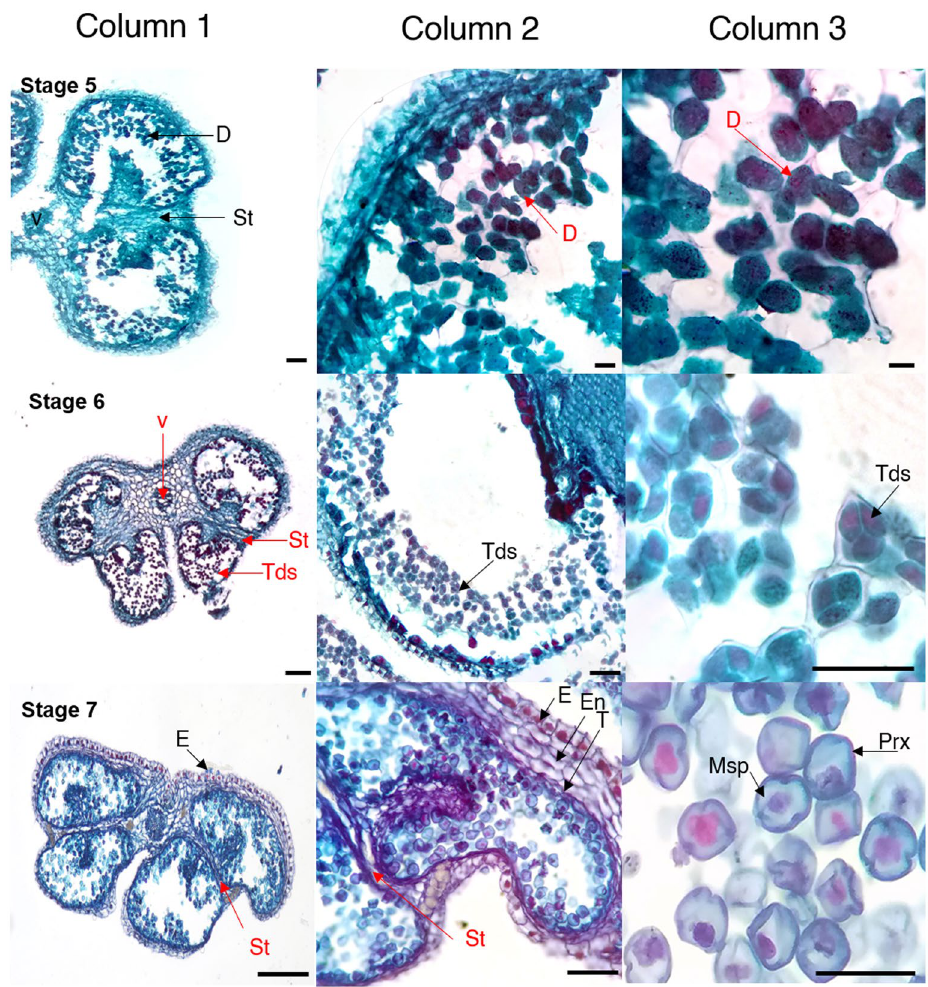
microspore, Prx primexin, St septum, T tapetum, Tds tetrads, V vascular tissue. Scale bars, 100 µm (column 1); 50 µm (column 2); 25 µm (column 3). Image created by the